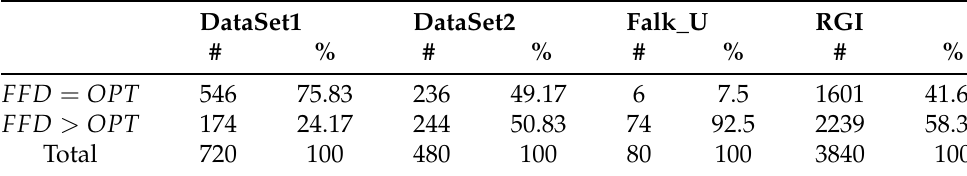
Table 2. Comparison with FFD for several further